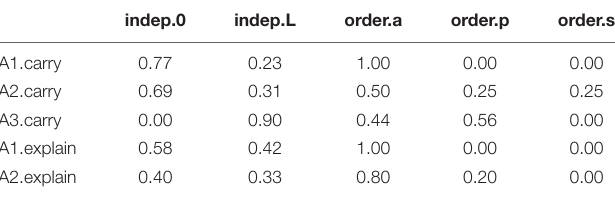
TABLE 5 | A partial sample of the table with behavioral profiles of